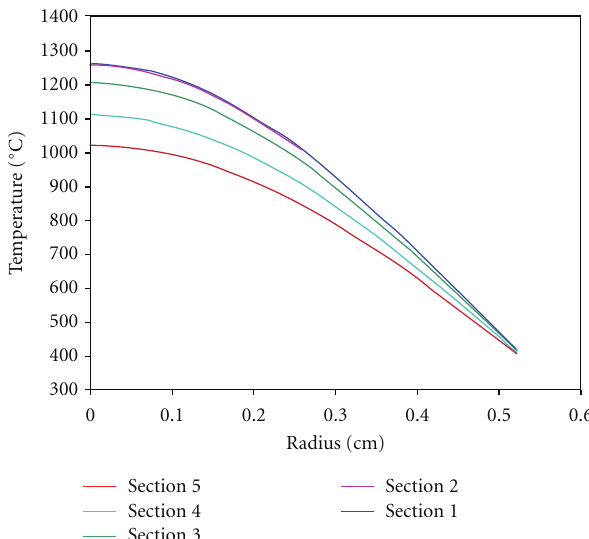
Figure 8: Pellet profile of the five axial sections of the MOX fuel A.1.3 at the top power ramp at